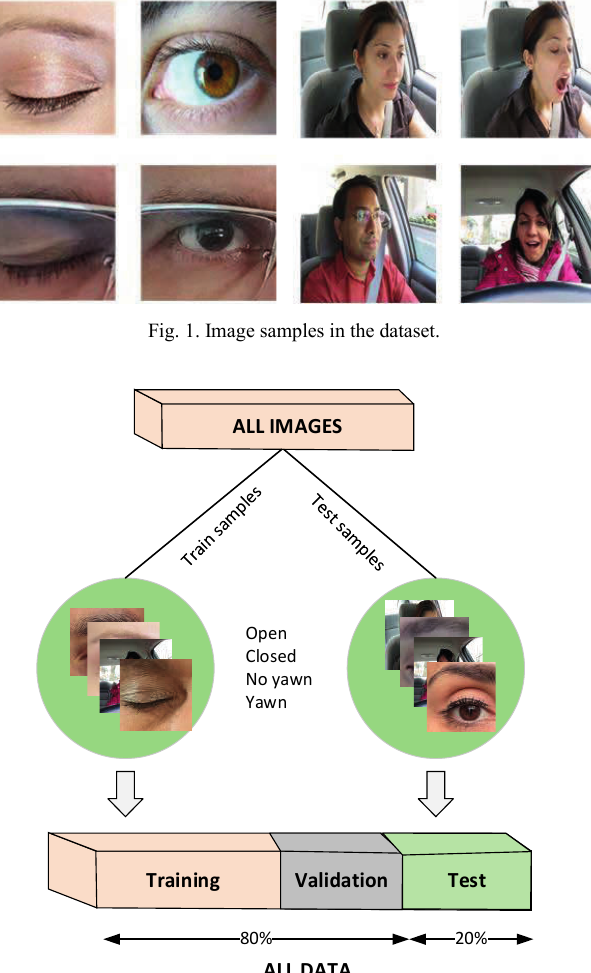
Fig. 2. Distribution of image samples used in training and testing phase.